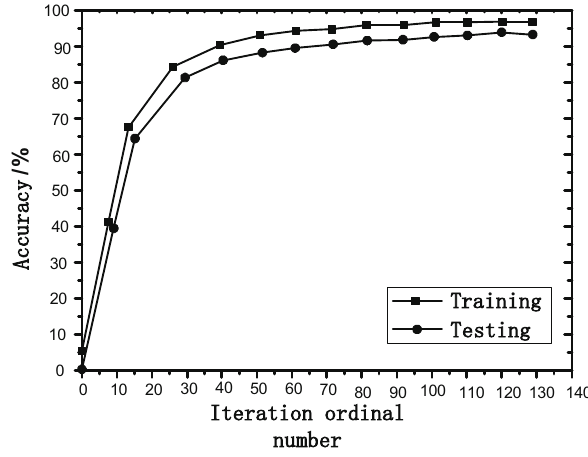
Figure 8: Accuracy curve of training and testing on the CK + dataset.